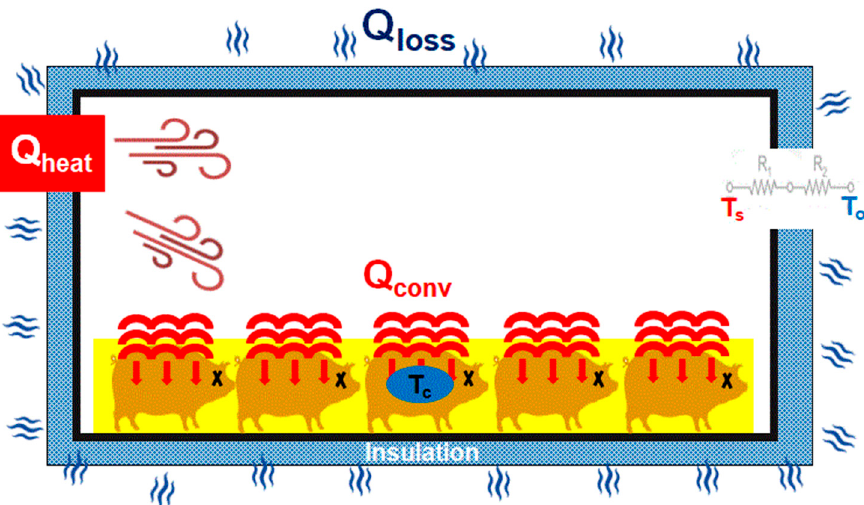
Figure 5. Schematic illustrating the key parameters considered in the heat treatment of swine carcass model. The hot combustion gas is injected into headspace; heat from headspace gas penetrates from the top of the carcass to the trailer floor. Heat dissipates from the insulated trailer in all directions. Q heat = heat energy output from heater, Q loss = total heat loss transferred by the process of conduction on wall surfaces with insulation, Q conv = convective heat transfer to the carcasses inside the trailer, To = outside air temperature, Ts = trailer the temperature setpoint, Tc = targeted pathogen inactivated temperature.